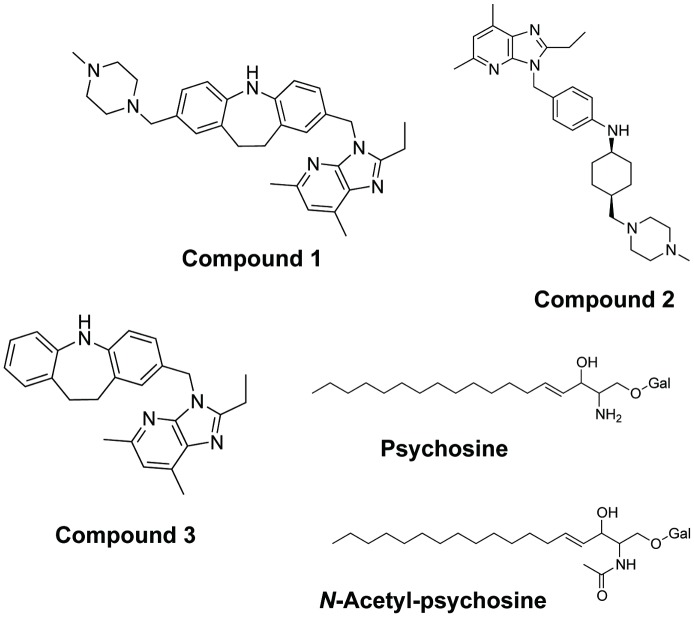
Chemical structure of imidazopyridine compounds, psychosine, and N-acetyl-psychosine.Chemical structures of imidazopyridine compounds, i.e., compound 1, 2, and 3, and psychosine (or galactosyl (Gal) sphingosine) and N-acetyl-psychosine are shown.